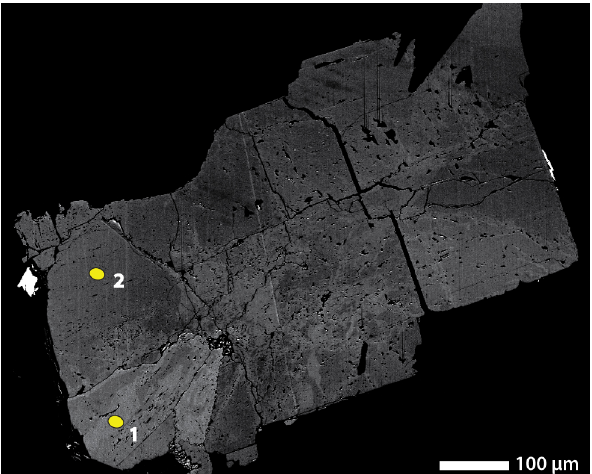
Figure A1. Backscatter electron image of monazite-(Nd) co-type material sample GRAESER 4 with the ovals representing the two measure- ment spots that yielded a Th–Pb age to